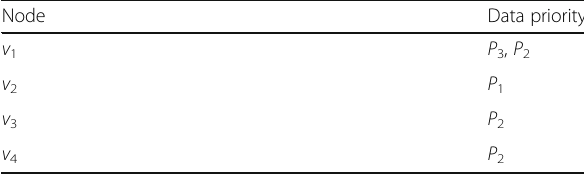
Table 4 The prioritization of data of each node in network 2 Node Data